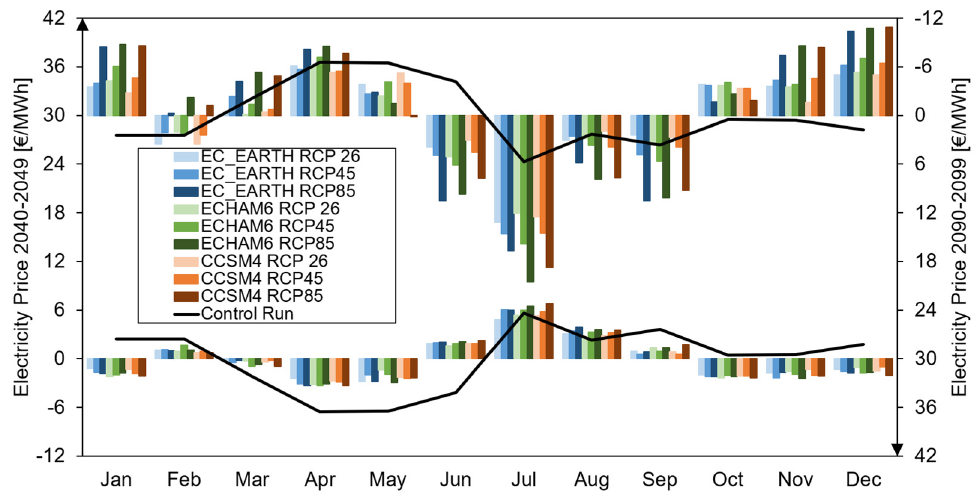
Figure 5. Electricity price monthly projections, climate driven share, compared with the yearly mean, in the mid-century period 2040–2049 (left y-axis) and end-of-century period 2090–2099 (right y-axis, values upside-down) against the control run period (2005–2013).